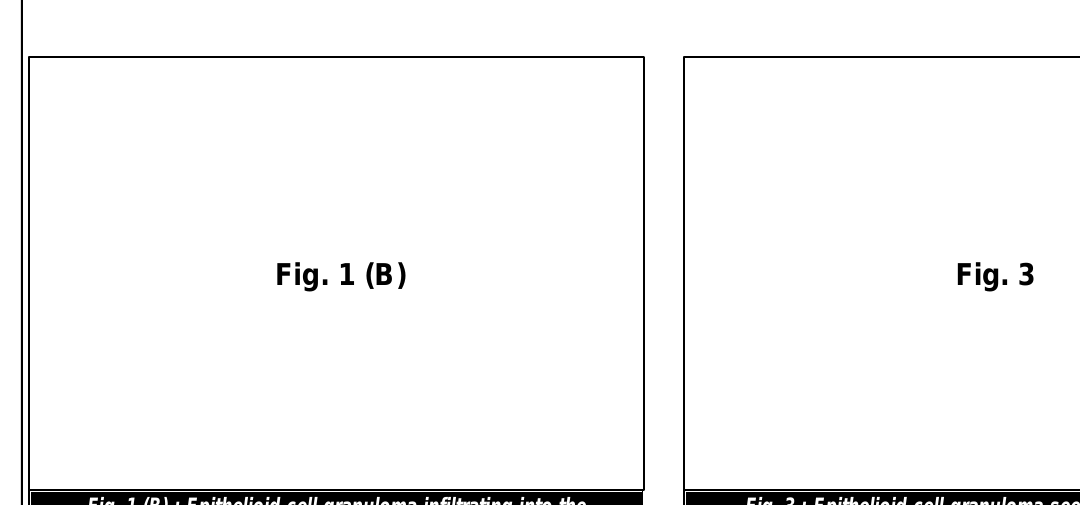
Fig. 1 (A) : Endometrium showing epithelioid cell granuloma with caseous necrosis (H & E stain, X 100).